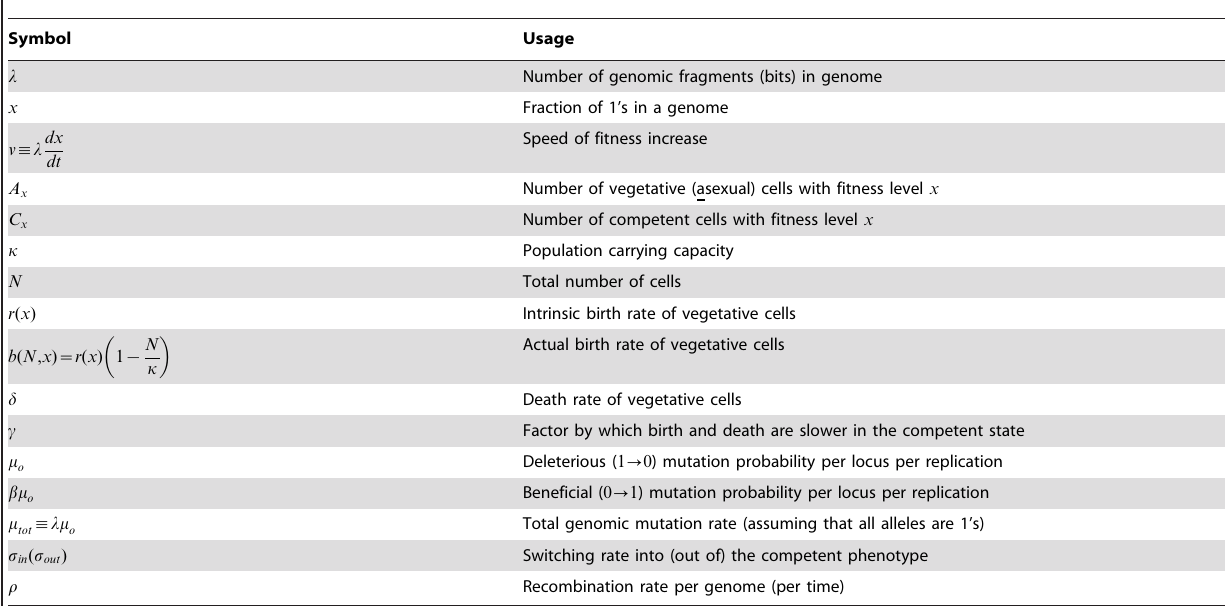
Table 1. Commonly used